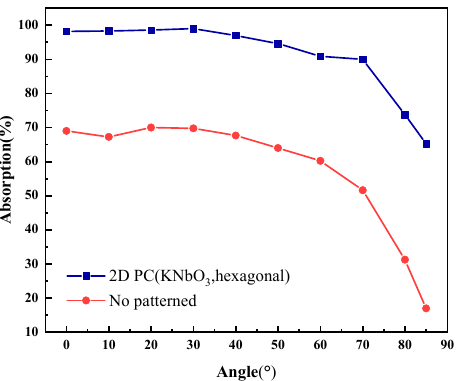
Figure 12. The dependance of the absorption efficiency for the two absorption layers on incidence angle.